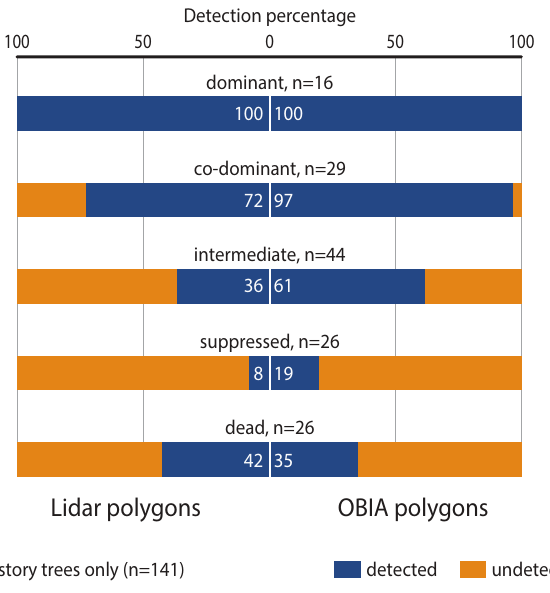
Figure 8. Overstory tree (DBH ≥ 19.5 cm) detection rates, classified by crown class. The detection rates of the dominant trees dropped considerably in the less-dominant tree crowns. Dead trees, including snags, were detected less than 50 percent of the time by both methods.